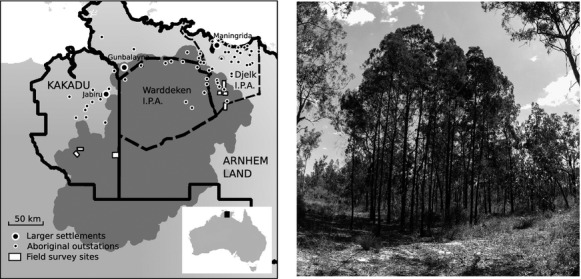
(A) shows field sites (white boxes) where the fire-sensitive conifer, Callitris intratropica, was surveyed in Arnhem Land and Kakadu National Park, while (B) illustrates Callitris grove formation, in which closed-canopy patches suppress graminoid fuels, exclude low-intensity savanna fires, and maintain small-scale (i.e., <0.5 ha) fire refugia for conspecific recruitment and a distinct shrub community (Trauernicht et al. 2013).